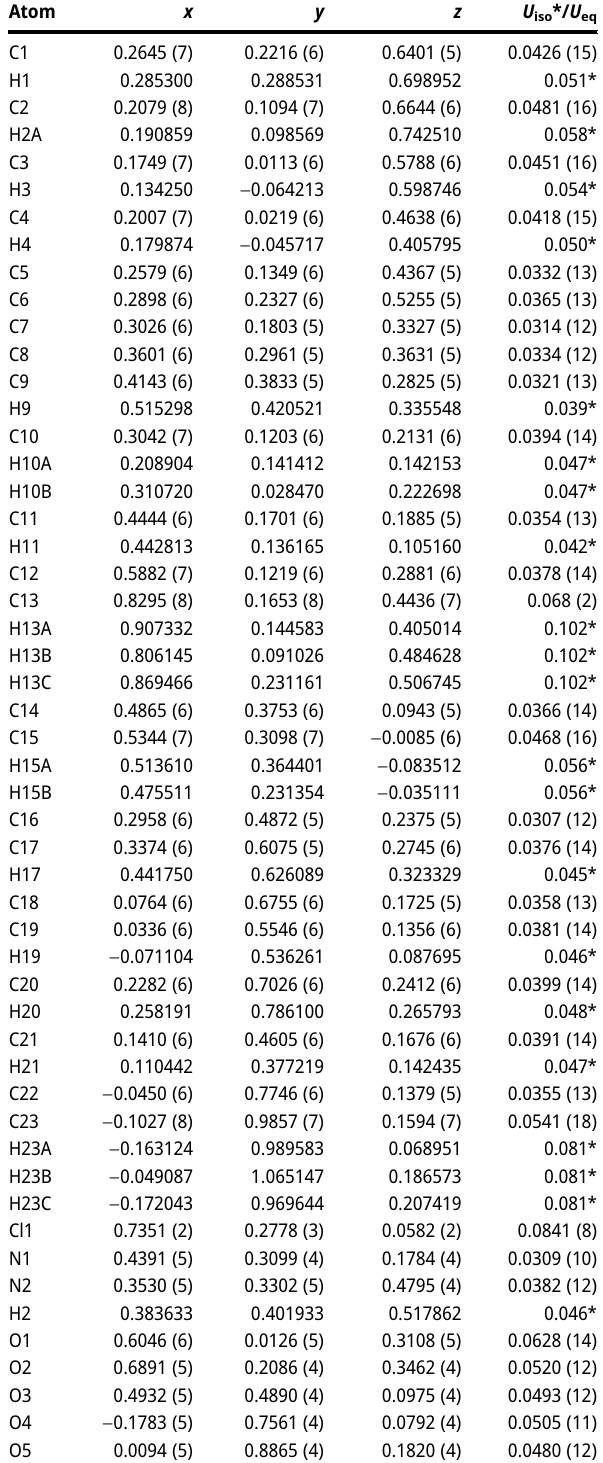
Table  : Fractional atomic coordinates and isotropic or equivalent isotropic displacement parameters (Å 